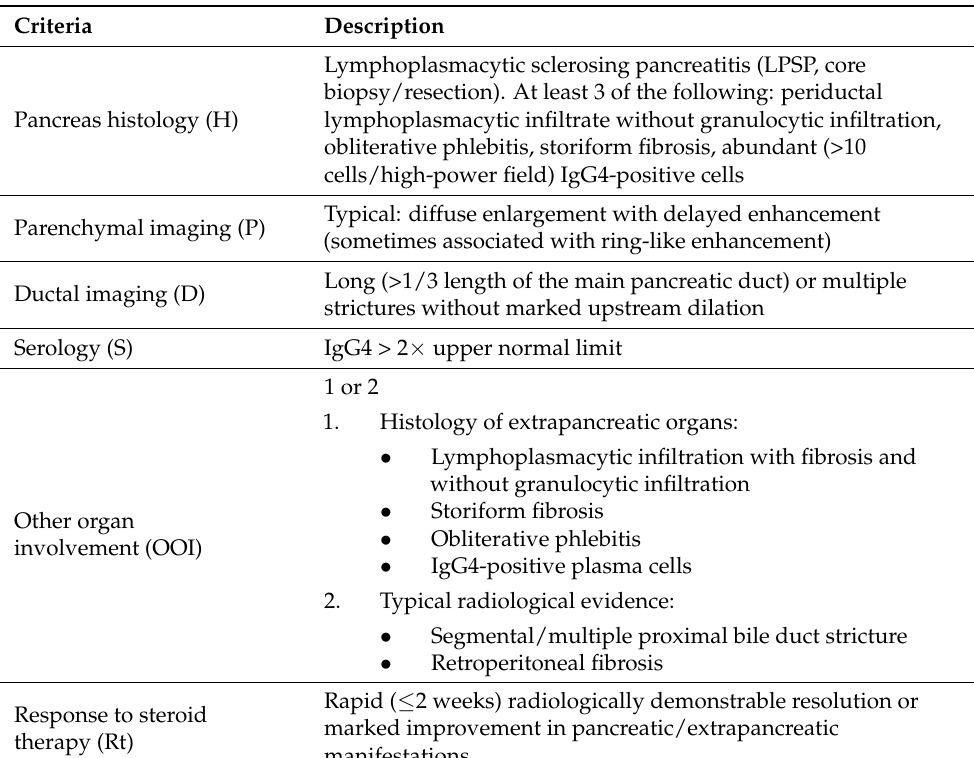
Table 4. Simplified international diagnostic criteria for type 1 autoimmune pancreatitis (created in accordance with Shimosegawa et al. [57]).